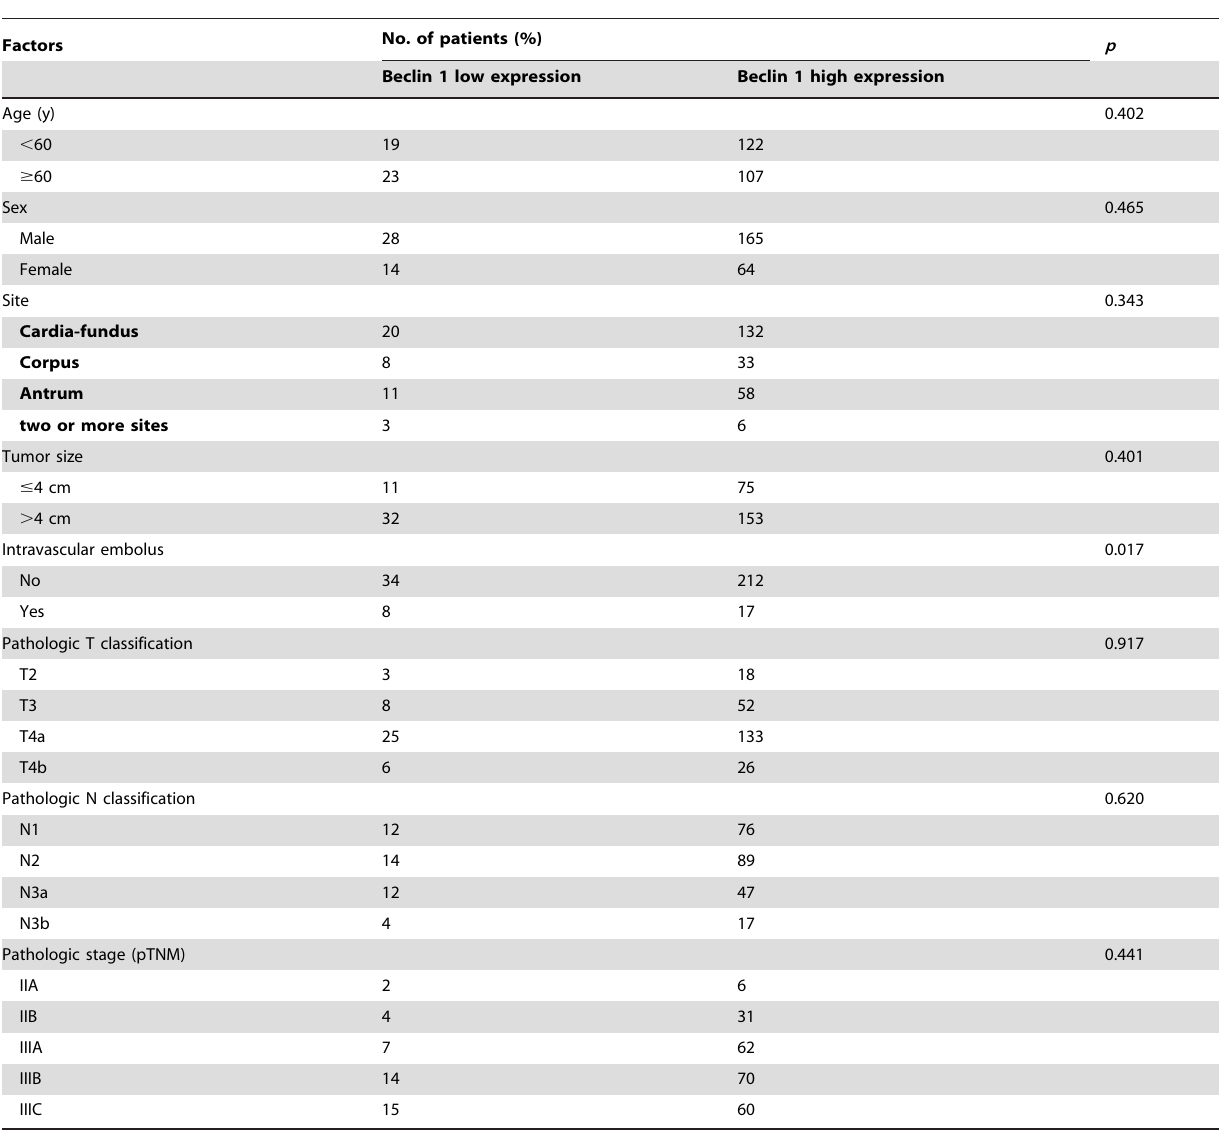
Table 1. Clinicopathologic correlation of beclin1 expression in gastric